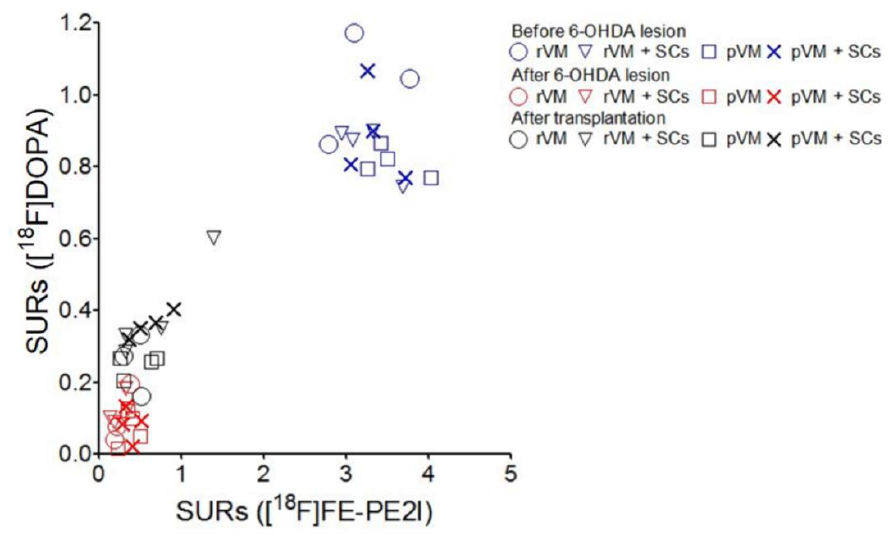
Figure 11. Pearson’s correlation analysis of 18 F-DOPA and [ 18 F]FE-PE2I in the grafted striatum of the rVM, rVM + SCs, pVM, and pVM + SCs groups. In all groups, Pearson’s R square was greater than 0.9, indicating a high correlation between the SUR of 18 F-DOPA and [ 18 F]FE-PE2I.